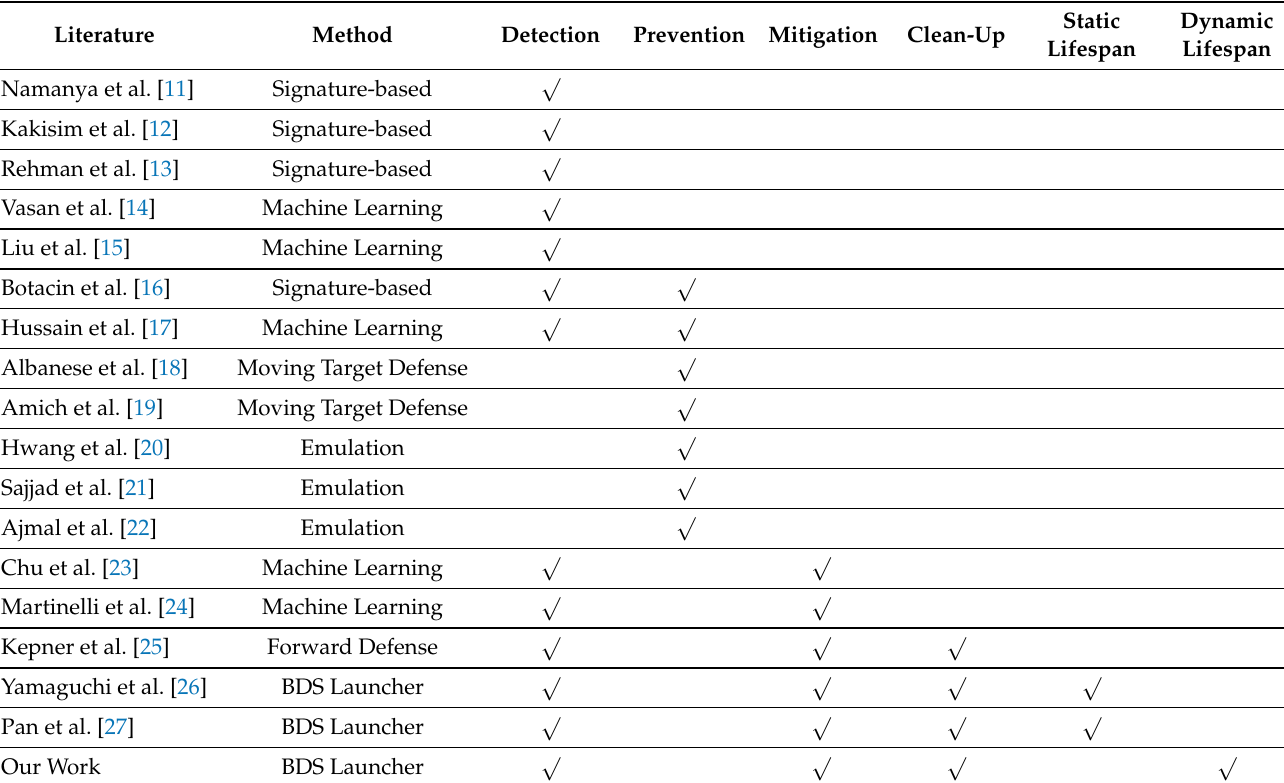
Table 1. Comparison of Related